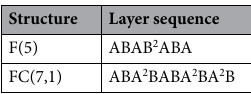
Table 1. The layers sequences of the quasi-periodic PhCs structures 31 .